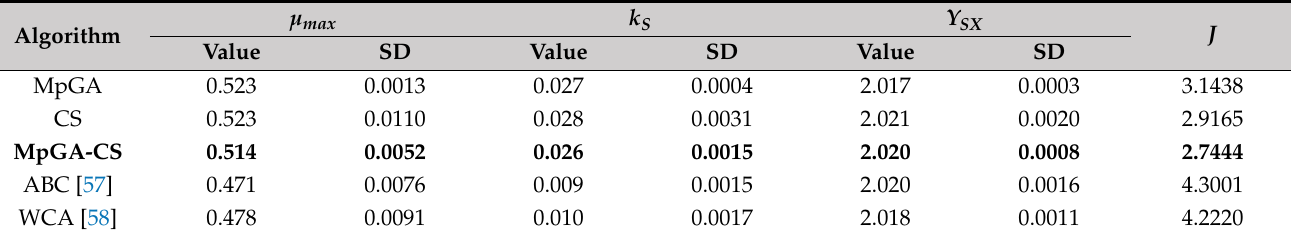
Table 3. Parameter estimates of E. coli FP model (Equation (1)).